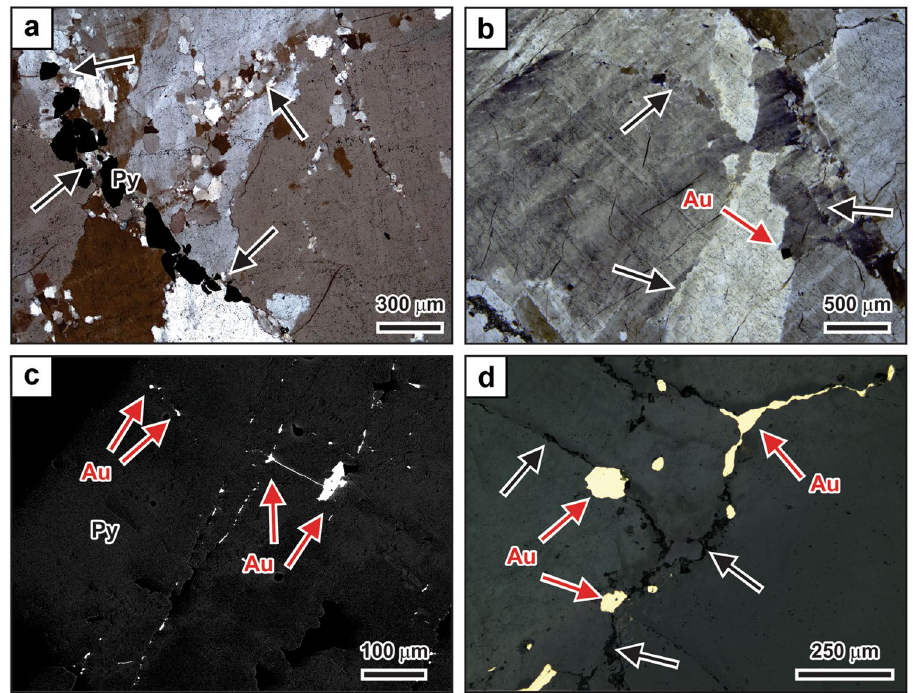
Figure 4. Petrographic characteristics illustrating paragenetic relationships. ( a ) Ribbons of anhedral pyrite and polycrystalline quartz aggregates (arrows) crosscutting originally elongate to blocky quartz grains. Crossed- polarized light. ( b ) Narrow bands of small polycrystalline quartz grains (arrows). The bands transect originally elongate to blocky grains or occur along original grain boundaries. Gold occurs at a grain boundary (red arrow). Crossed-polarized light. ( c ) Backscatter electron image of pyrite grain exhibiting patchy compositional zoning. Micron-sized gold occurs as inclusions in the pyrite and along microfractures transecting the pyrite (red arrows). Subtle patchy zoning in the pyrite is caused by variations in the As content. ( d ) Late gold (red arrows) located along quartz grain boundaries (arrows) in reflected light. Au = gold; Py =